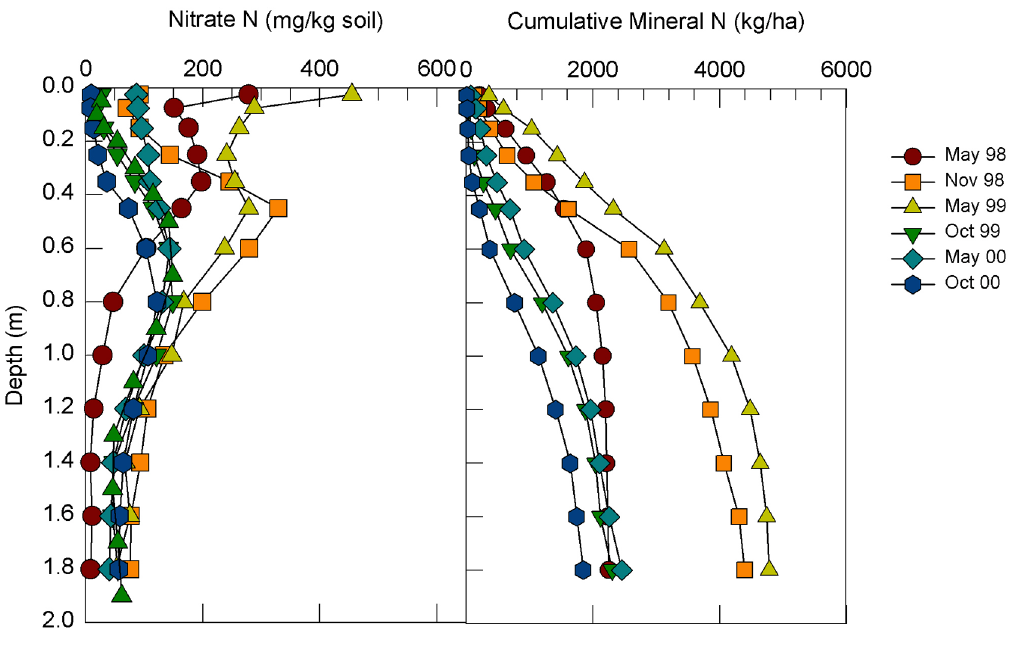
FIGURE 3. Mineral N values in the 0- to 1.9-m soil layer at sowing of the oats (May 98), after harvest of the oats (November 1998; October 1999, October 00), and after harvest of the maize (May 1999, May 00). The site was irrigated from December through March each year with treated effluent (see Table 1).